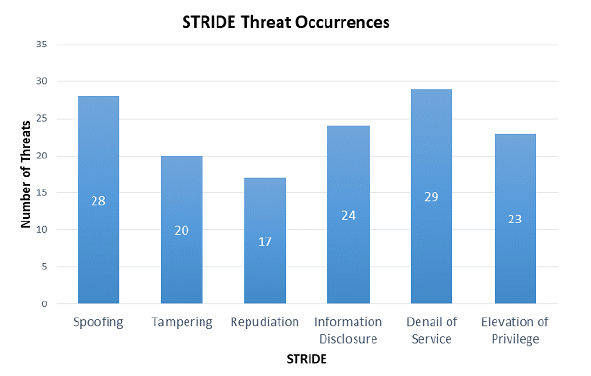
Figure 7. STRIDE Threats